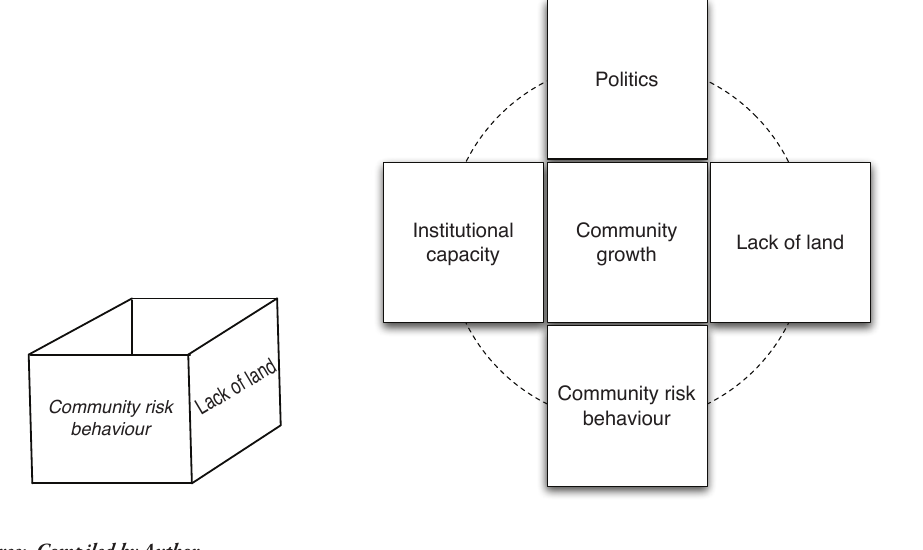
Figure 1:The box analogy as an overview of the challenges for disaster risk reduction in Imizamo